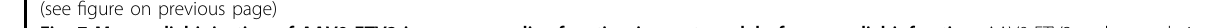
Fig. 7 Myocardial injection of AAV9-ETV2 improves cardiac function in a rat model of myocardial infarction. AAV9-ETV2 and control virus were injected into MI hearts of rats followed by image and functional analysis. a Optical images of sacri fi ced hearts 8 weeks after injection. White circle shows the area of fi brotic scar formation. b Representative images of echocardiography. c Quantitative analysis of EF and FS, *** p < 0.001. d Analysis of 18 F-FDG cardiac uptake PET images with left ventricular polar maps (upper panels). Color on the map represents summed value of 18 F- FDG uptake in the left ventricle. Cardiac 18 F-FDG PET image was reoriented to the short-axis (SA), the horizontal long-axis (HLA), and the vertical long- axis (VLA). Quanti fi cation of 18 F-FDG PET image in 20-segment polar map (bottom panels). Scores (%) of 18 F-FDG uptake in the infarct area showed signi fi cant reduction in AAV-ETV2 group compared to that in the control group ( n = 6, p <